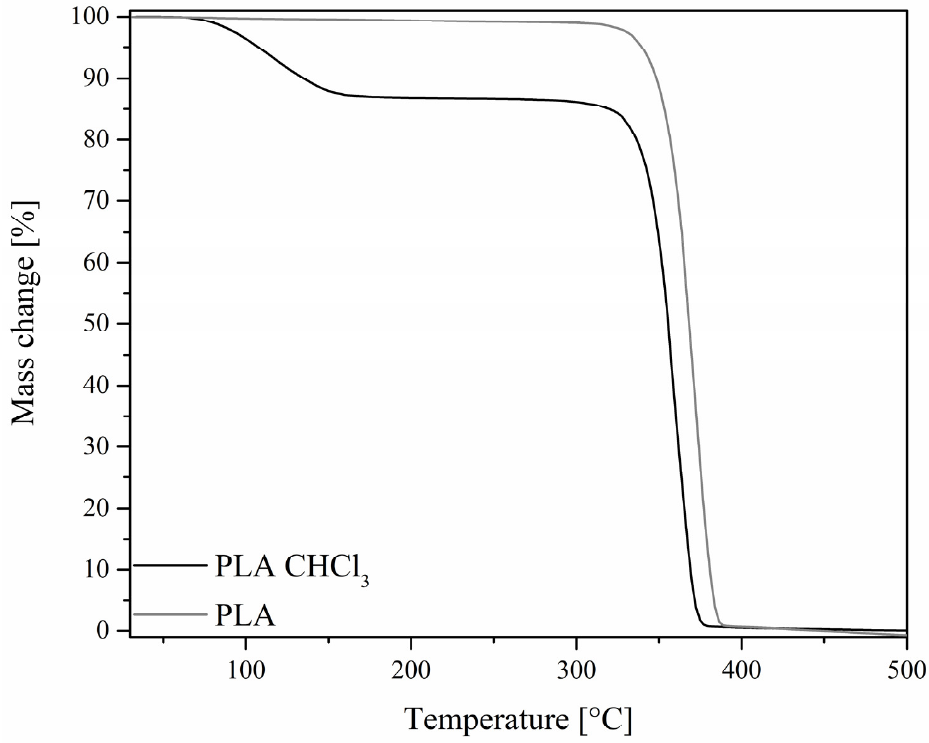
Figure 5. TGA curves of hot-pressed and solvent-cast PLA foils. It is evident that the reference PLA membrane shows the highest initial mass loss, which corresponds to the highest amount of residual chloroform in the sample. This is due to the molecules of the organosilicon additives taking up the polymer’s free volume, leaving less volume for the solvent. This correlates with the molecule size, as SSQ-8Cl and iBu 7 SSQ-OEt samples show the least amount of solvent absorbed, while small molecules of additives take up the free volume the most effectively. Silsesquioxane trisilanols are known for existing in a dimeric form in aprotic environments or a solid state [47,48], and SS-Limonene is a large molecule due to the spherosilicate corona and large, cycloaliphatic substituents. Also, different temperatures of maximum mass loss at the first stage, measured by DTG peak (T max1 ), show the interaction between additive molecules and polymer chains, iBu 7 SSQ-3OH, SSQ-8Cl and iBu 7 SSQ-OEt increasing chain mobility and